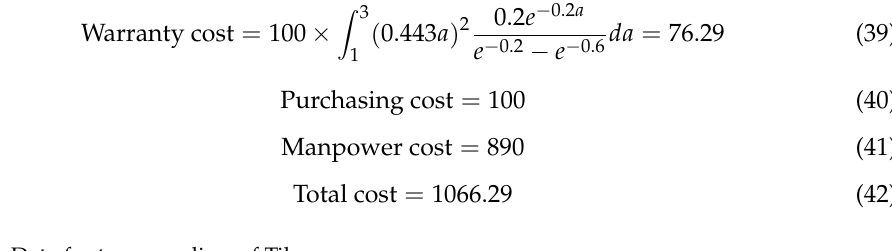
Table 11. Data for two suppliers of Tile.